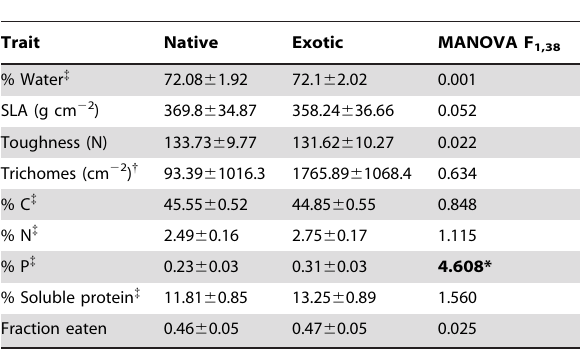
Table 1. Mean ( 6 SE) values for nine measured traits of 19 exotic and 21 native species co-occurring in forest understory